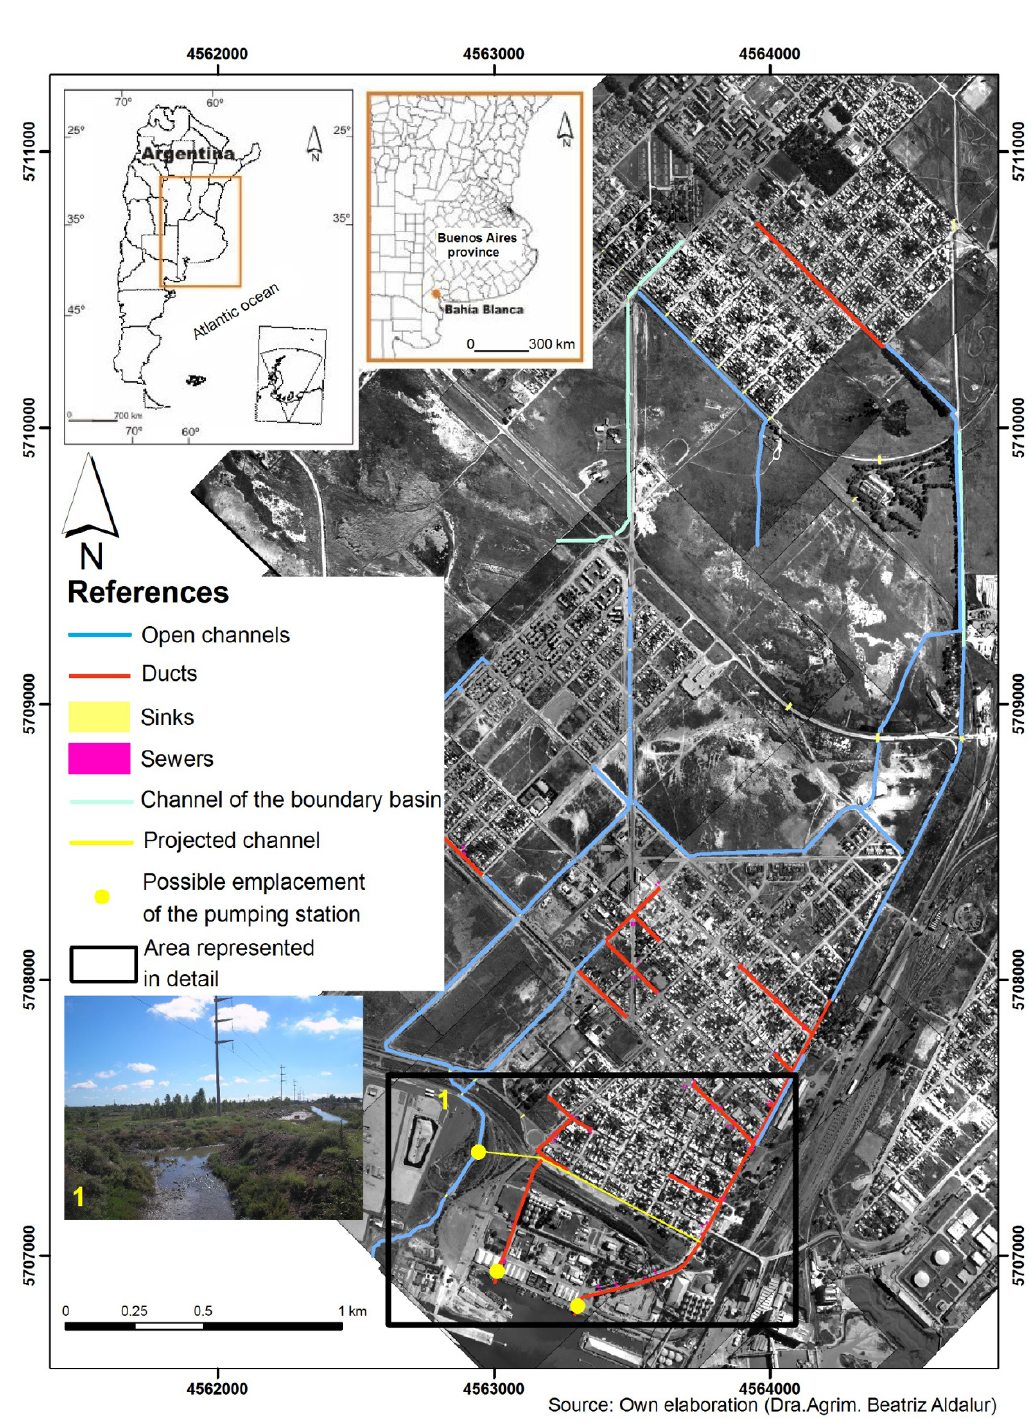
Figure 7. Location of the proposed channel and pumping